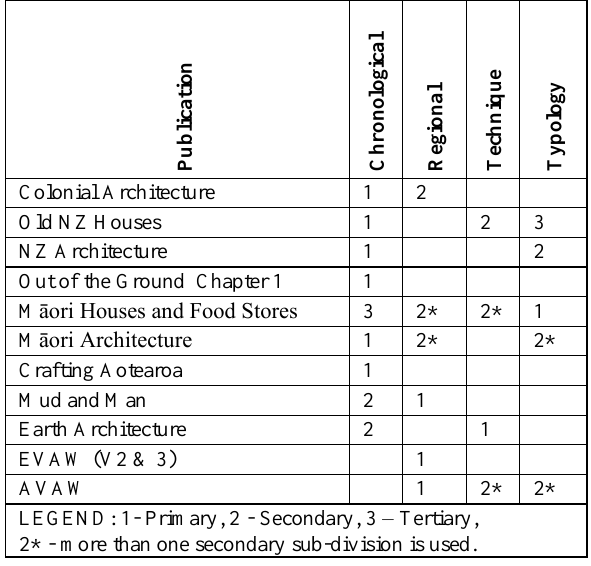
Table 1. Structural hierarchy of histories and